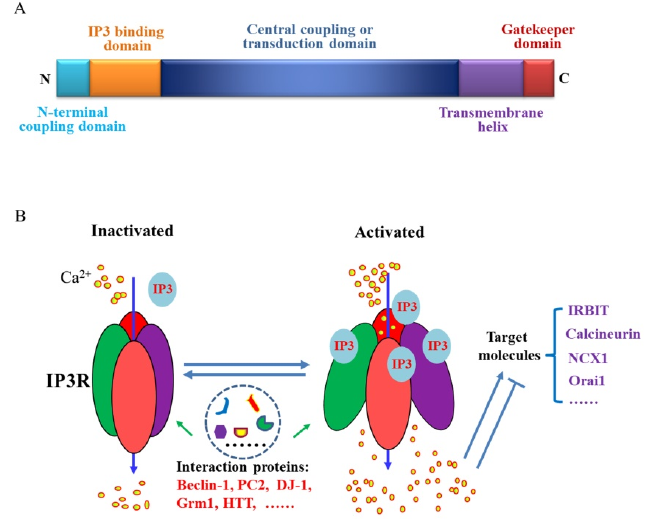
Figure 1. Diagram of the structure and regulation of the inositol 1,4,5-trisphosphate receptor (IP3R) channel. ( A ) Five domains of IP3R. ( B ) Regulation of IP3R by IP3, Ca 2+ and interaction proteins.